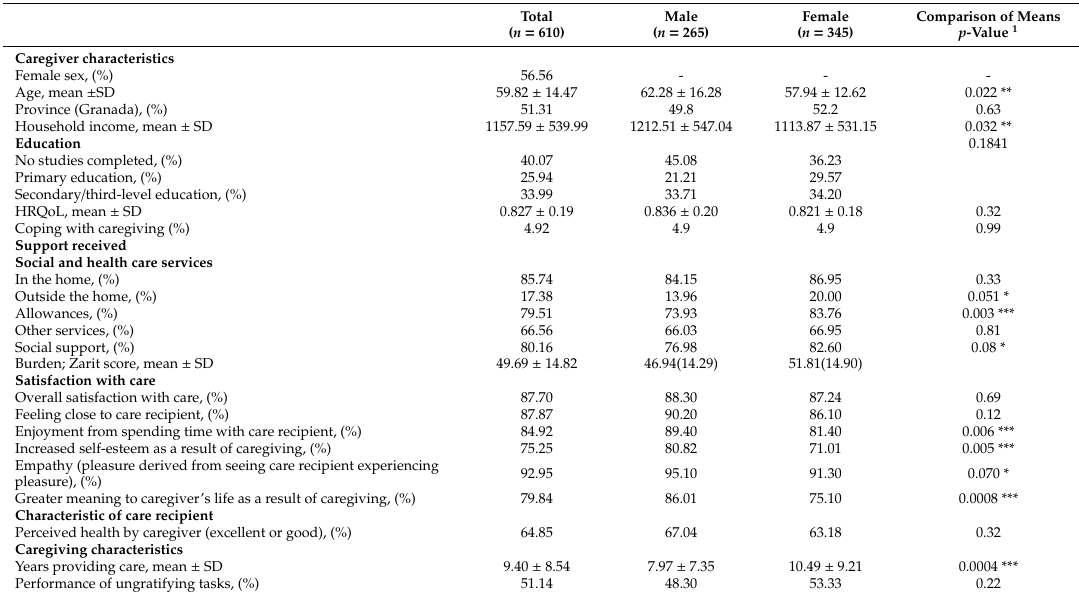
Table 1. Distribution of caregiver characteristics by